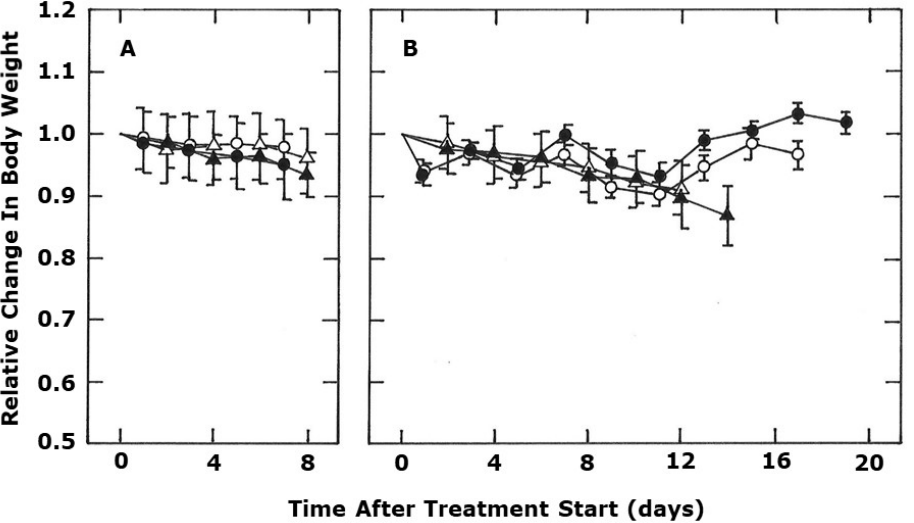
Figure 4. The e ff ect of di ff erent treatments on the body weight of C3H mammary carcinoma bearing CDF1 mice. Measurements were started when tumors had reached 200 mm 3 (day 0) and show body weight changes relative to the starting value. In ( A ), the symbols are for control mice (open triangles), or mice treated with either anti-PD-L1 (closed triangles), anti-PD-1 (open circles), or anti-CTLA-4 (closed circles). ( B ) shows the e ff ect of treating mice with either CA4P (open triangles), CA4P + anti-PD-L1 (closed triangles), OXi4503 (open circles), or OXi4503 + anti-CTLA-4 (closed circles). The actual treatments were CA4P (100 mg / kg) or OXi4503 (50 mg / kg) i.p. injected on days 0, 3, 7, and 10, or the checkpoint inhibitors (10 mg / kg) i.p. injected on days 1, 4, 8, and 11. All results show means ( + 1 SEM) from at least 7 mice / group. A Student’s t -test was used to compare each checkpoint inhibitor with controls, or each VDA with the corresponding VDA + checkpoint inhibitor, and no significant ( p < 0.05) di ff erences were found.